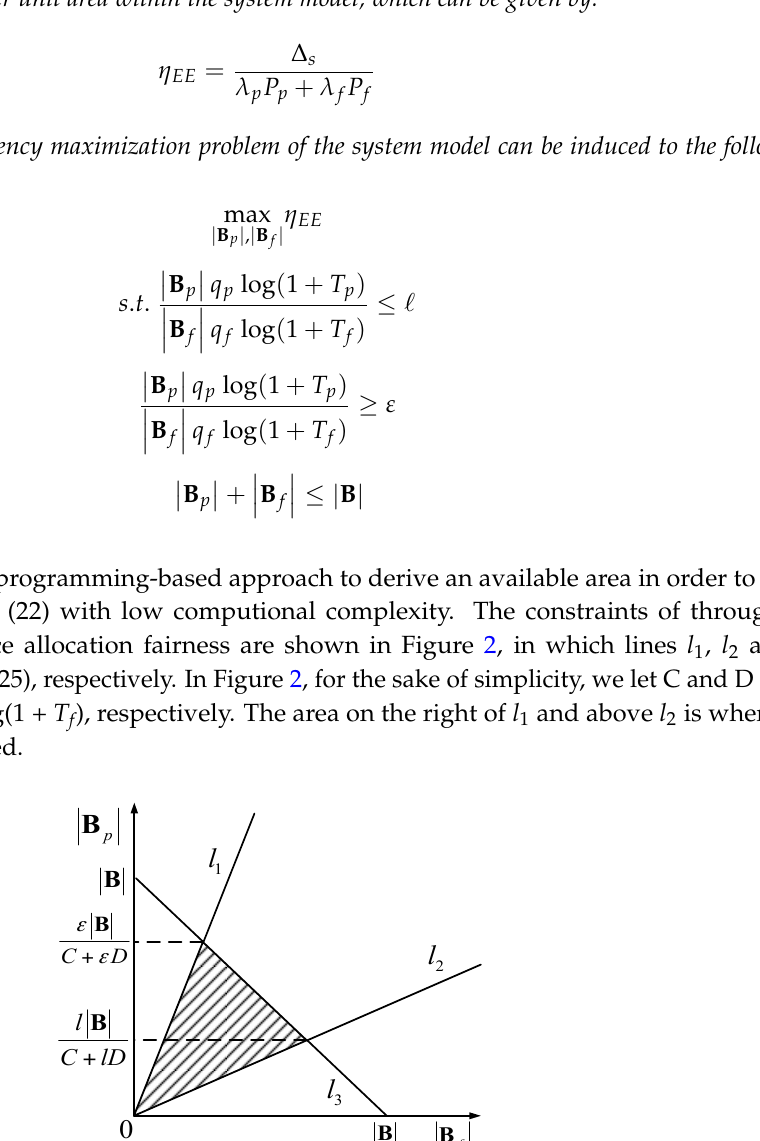
Table 1. Simulation parameters.